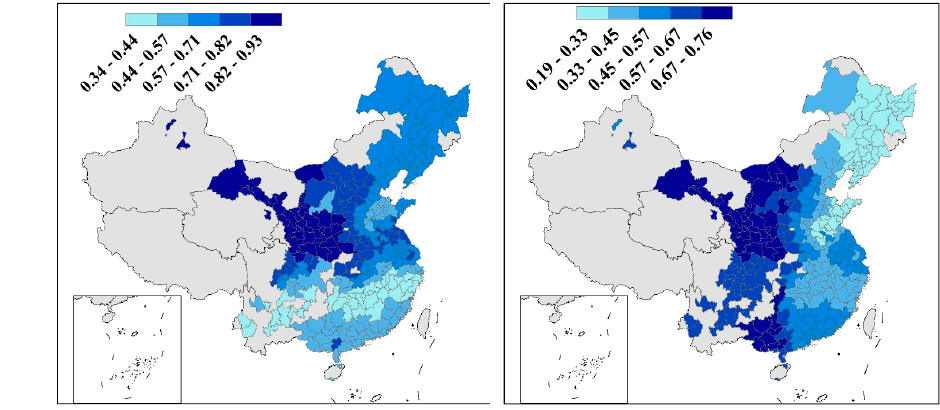
Figure 4. Spatial distributions of MGWR’s local R 2 in 2005, 2010, 2015, and 2018.